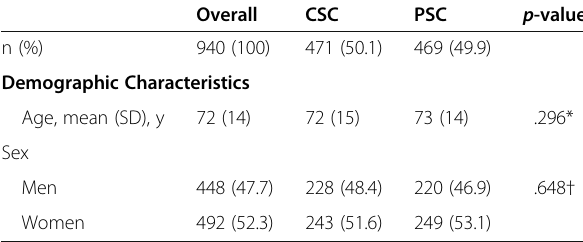
Table 1 Demographic characteristics of patients who received CTA Overall CSC PSC p